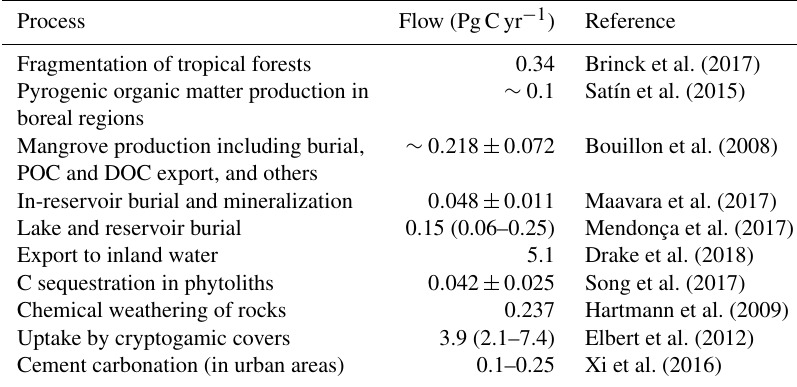
Table 3. Summary of studies on other minor carbon